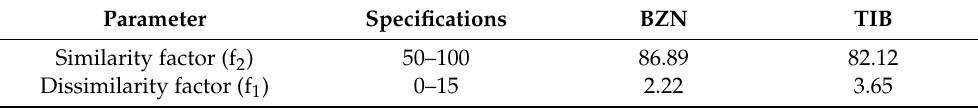
Table 5 . In vitro release kinetics of BZN and TIB from the optimized (F9) formulation. Model